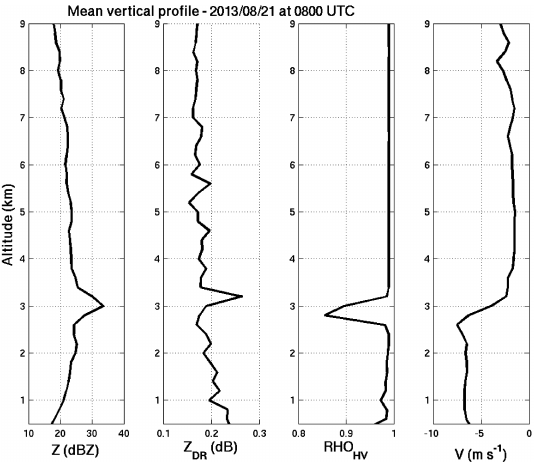
Figure 11. Mean vertical profiles of reflectivity, differential reflec- tivity, correlation coefficient and Doppler velocity observed on 21 August 2013 at